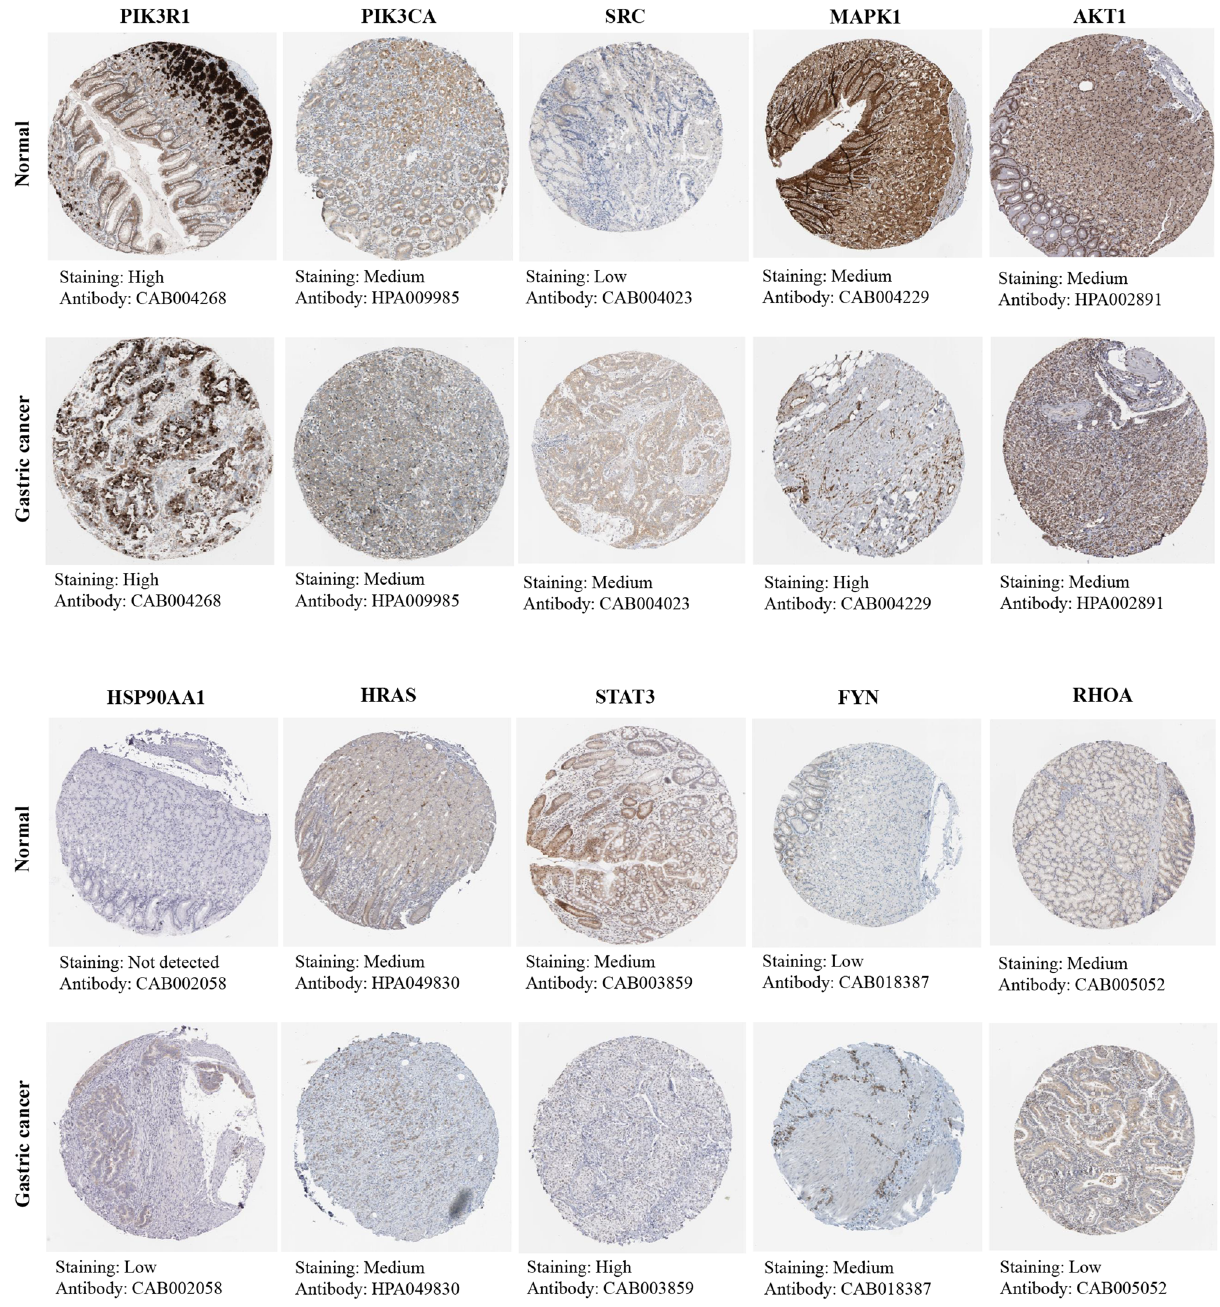
Figure 10. Immunohistochemical images of hub gene protein expression levels in the HPA